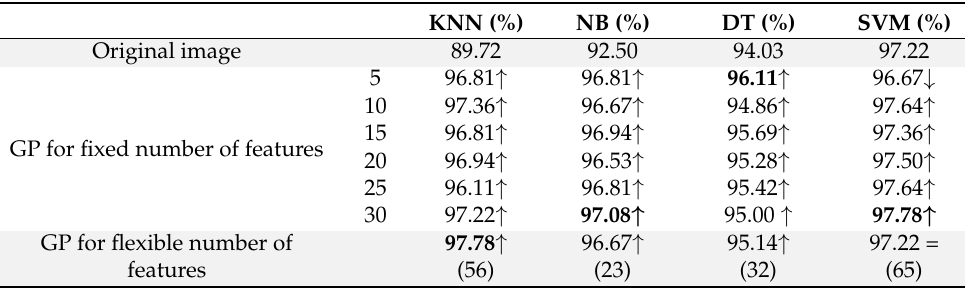
Figure 9. Classification results of KNN, NB, DT, and SVM by using original images ( a – d ); and GP learned features with the highest accuracies ( e – h ). Table 2. Classification accuracies of KNN, NB, DT, and SVM using original image and different numbers of features learned by